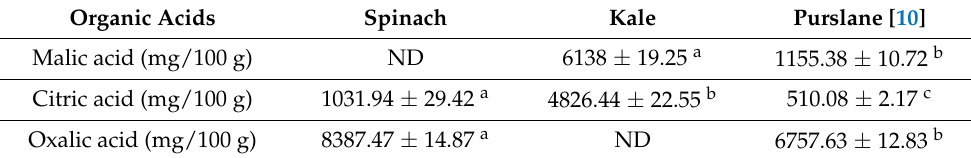
Table 5. Organic acid content in spinach, kale, and purslane [10] (Mean ± SD; n = 3), dry weight. Organic Acids Spinach Kale Purslane [10] Malic acid (mg/100